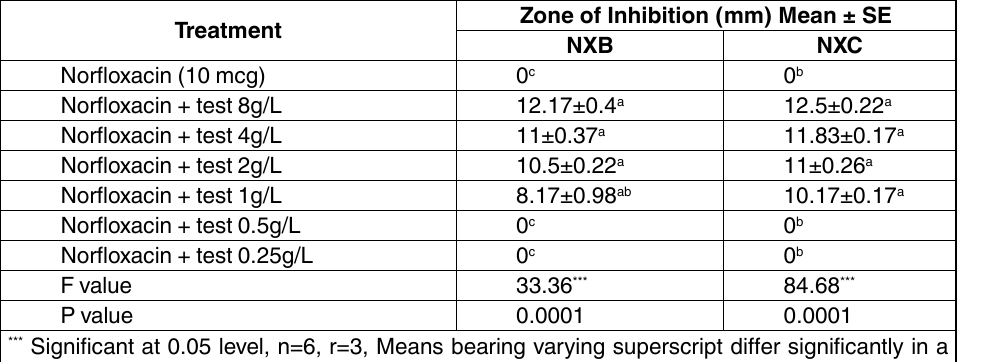
Table 2 . Zone of inhibition (mm) of quinolone resistant S. aureus against norfloxacin with different combinations of berberine and